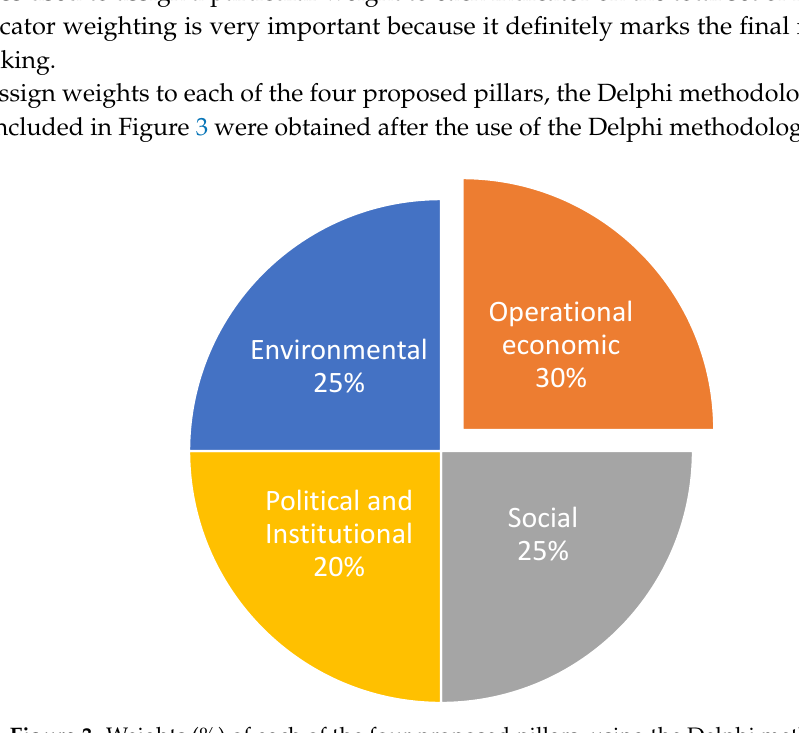
Figure 3. Weights (%) of each of the four proposed pillars, using the Delphi methodology.